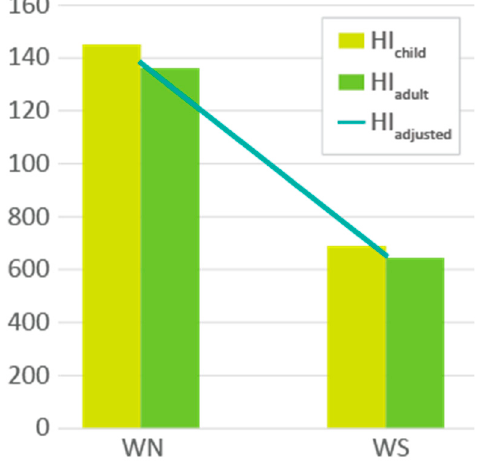
Figure 8. Systemic toxicity of well water samples.